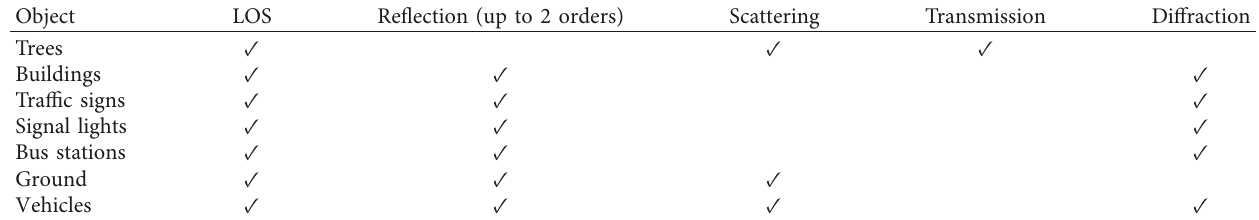
Table 4: Propagation mechanism.